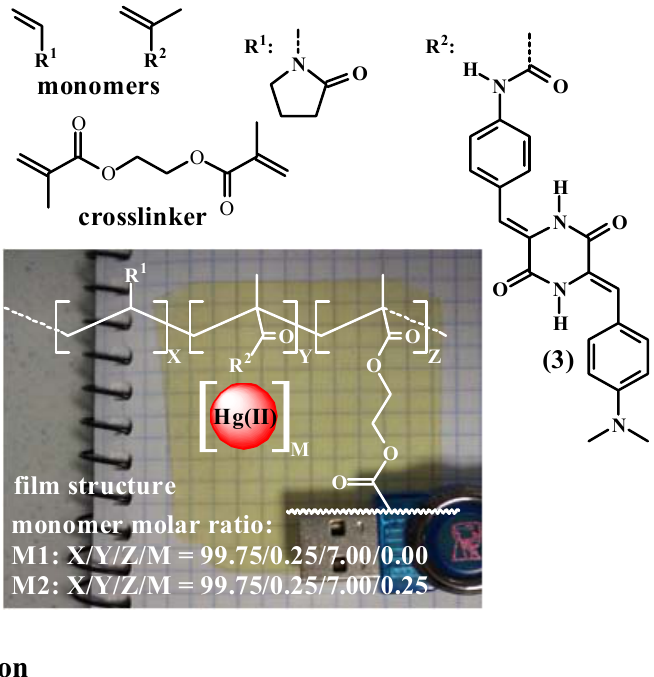
Figure 1. Chemical structures of the monomers and the copolymer. The copolymer is shown over a digital picture of the sensory